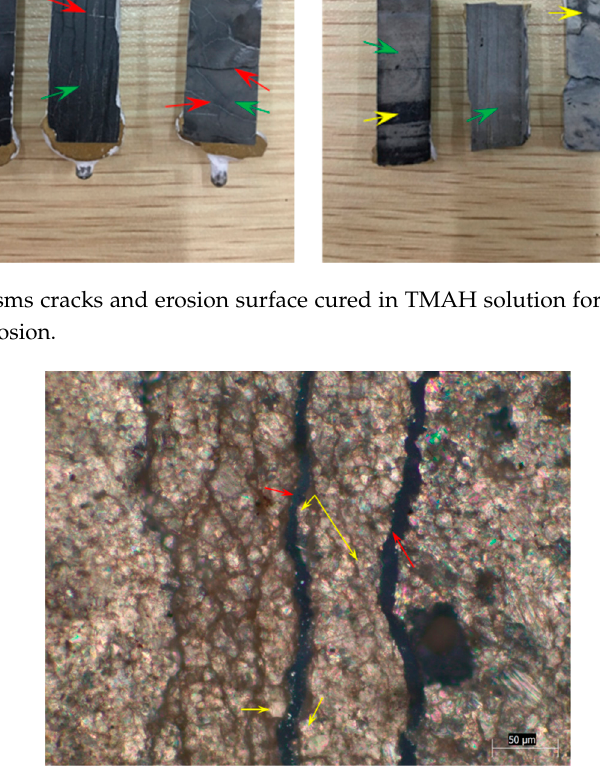
Figure 9. Rock prism cracks of CX2 cured in TMAH solution for 154 days.